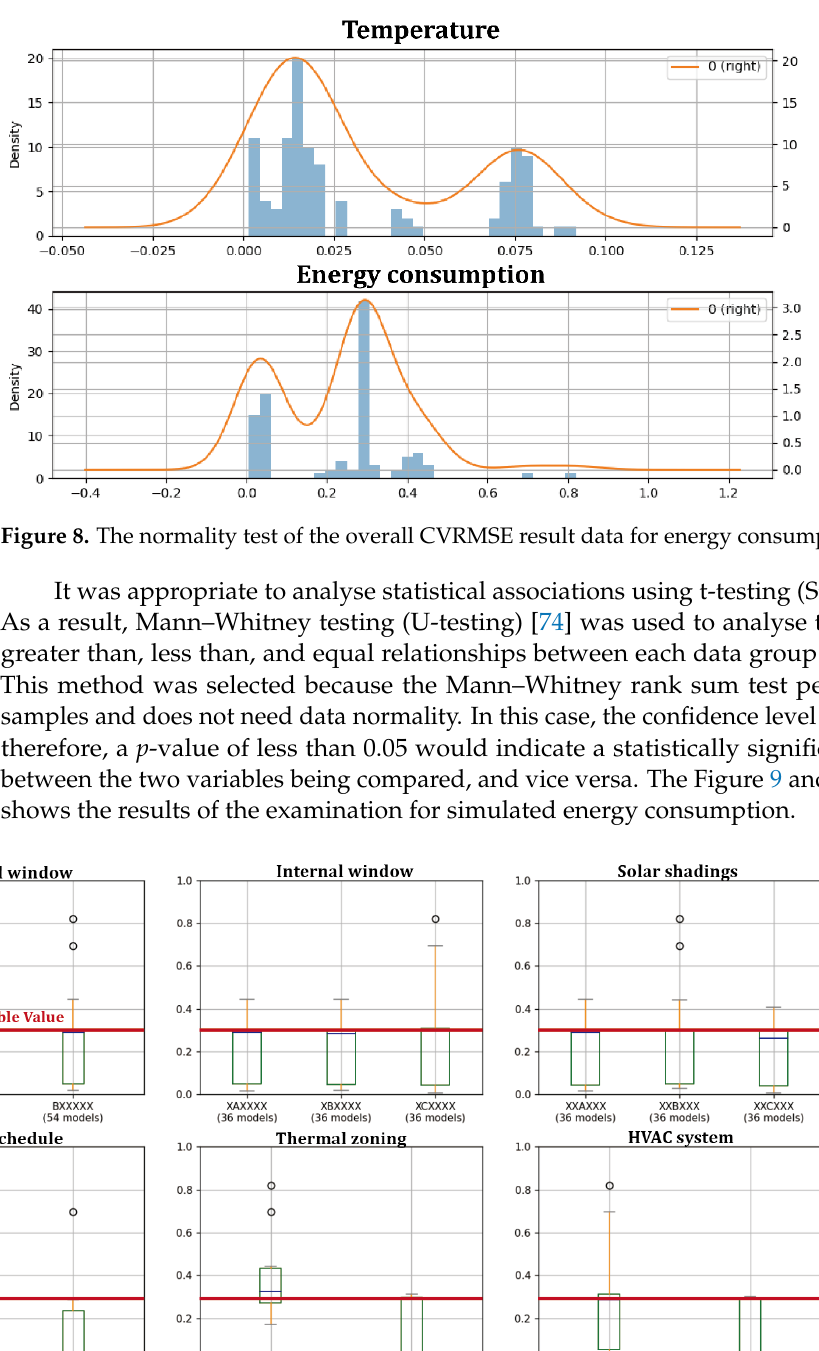
Figure 7. Computational load against CVRMSE (zone mean air temperature).